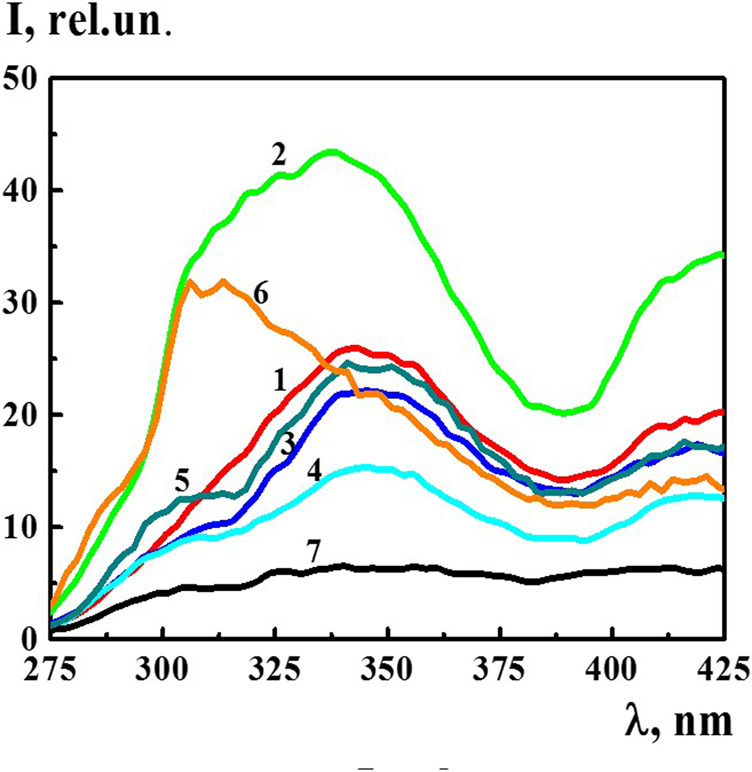
The fluorescence spectra (λ
ex225 nm) of the 4-AP systems at 1) 1·10−8 М, 2) 1·10−12 М, 3) 1·10−16 М, 4) 1·10−20 М, 5) S-22, 6) S-24, and 7) diluted double distilled water (fourth centesimal dilution corresponding to 1·10−8 M of the 4-AP system). Measurements were performed at 25 ± 0.1°C.